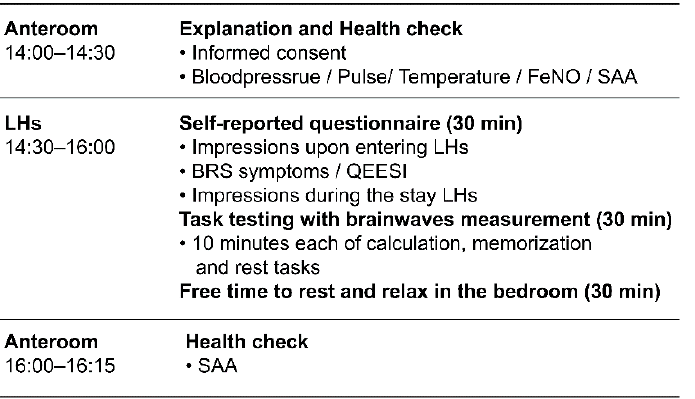
Figure 2. Work flowchart of the evaluation test. Table 1. Results of participants’ salivary amylase and FeNo concentrations stratified for LHs ( n =